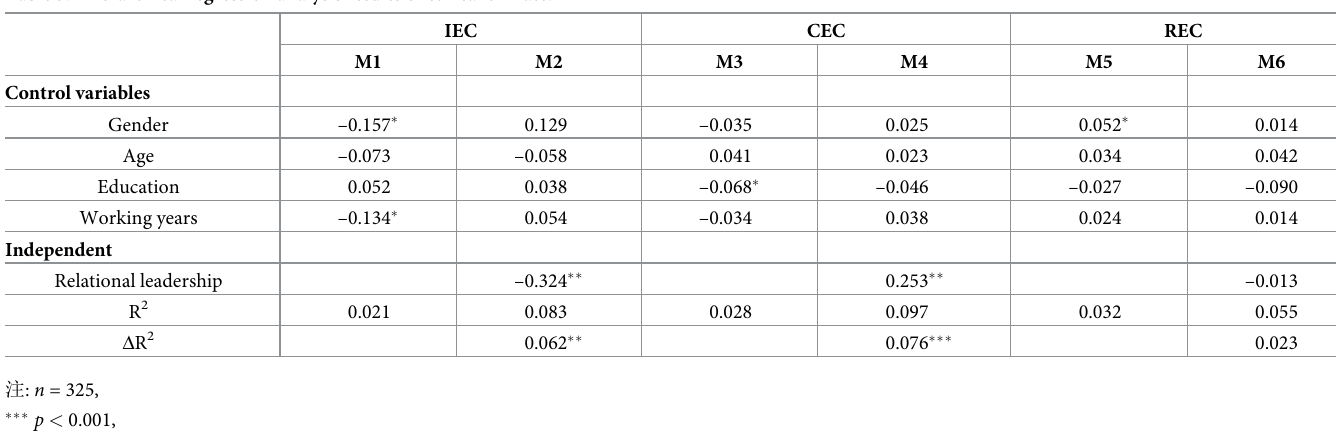
Table 3. Hierarchical regression analysis results of ethical climate.